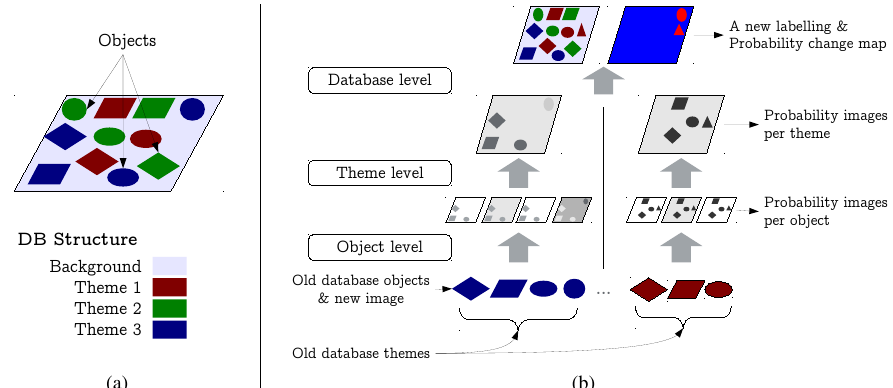
Figure 1: (a) Database structure and (b) our hierarchical inspection